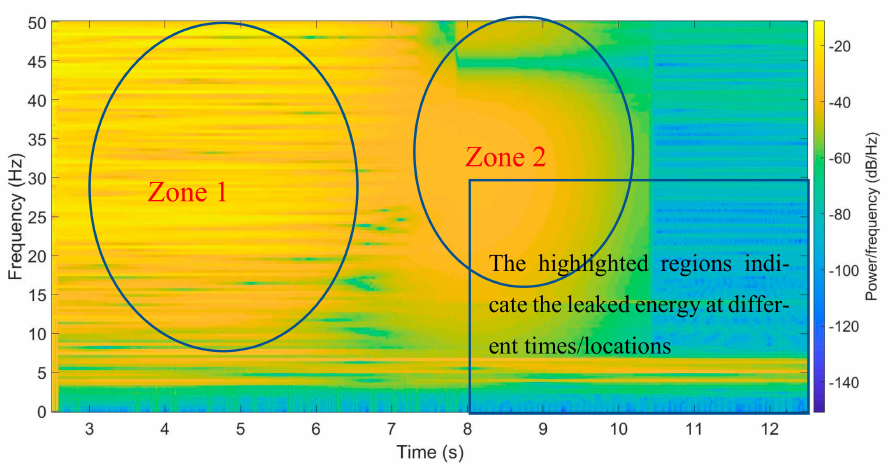
Figure 28. STFT results of vehicle’s right rear axle acceleration difference between the 60% damage case and the healthy bridge.